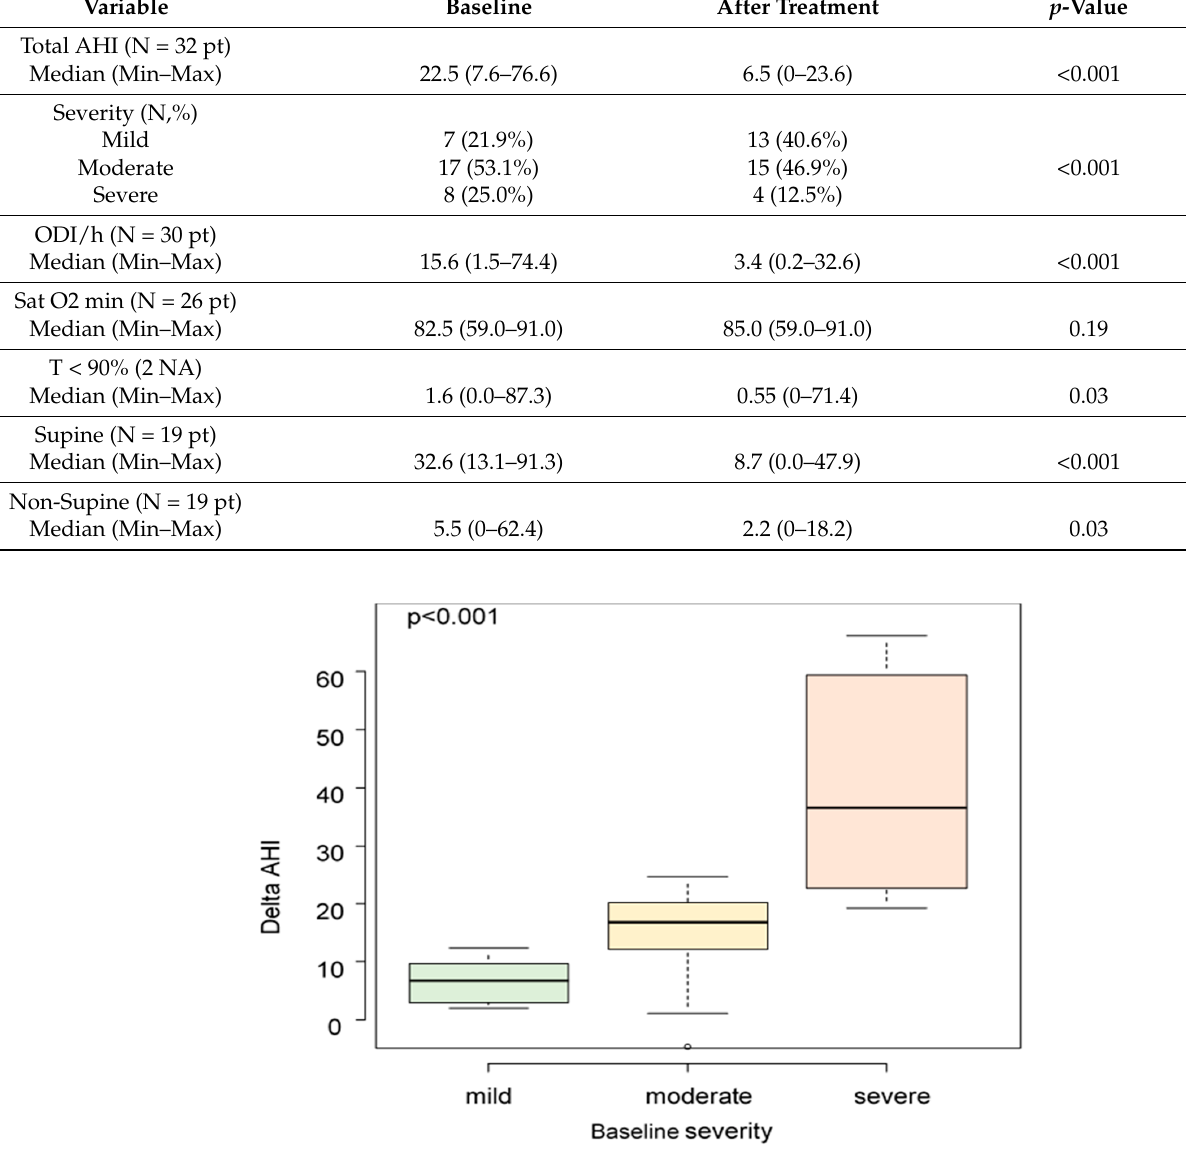
Figure 1. AHI variation at different baseline severities ( p -value < 0.001). The mean BMI was 26.2 ± 4.4 at baseline and remained stable at 6 months. There was no statistically significant correlation between the BMI and the AHI reduction, nor be- tween the grade (expressed in millimeters) of mandibular advancement and the AHI re- duction. Similarly, there was no statistically significant difference in the AHI reduction in